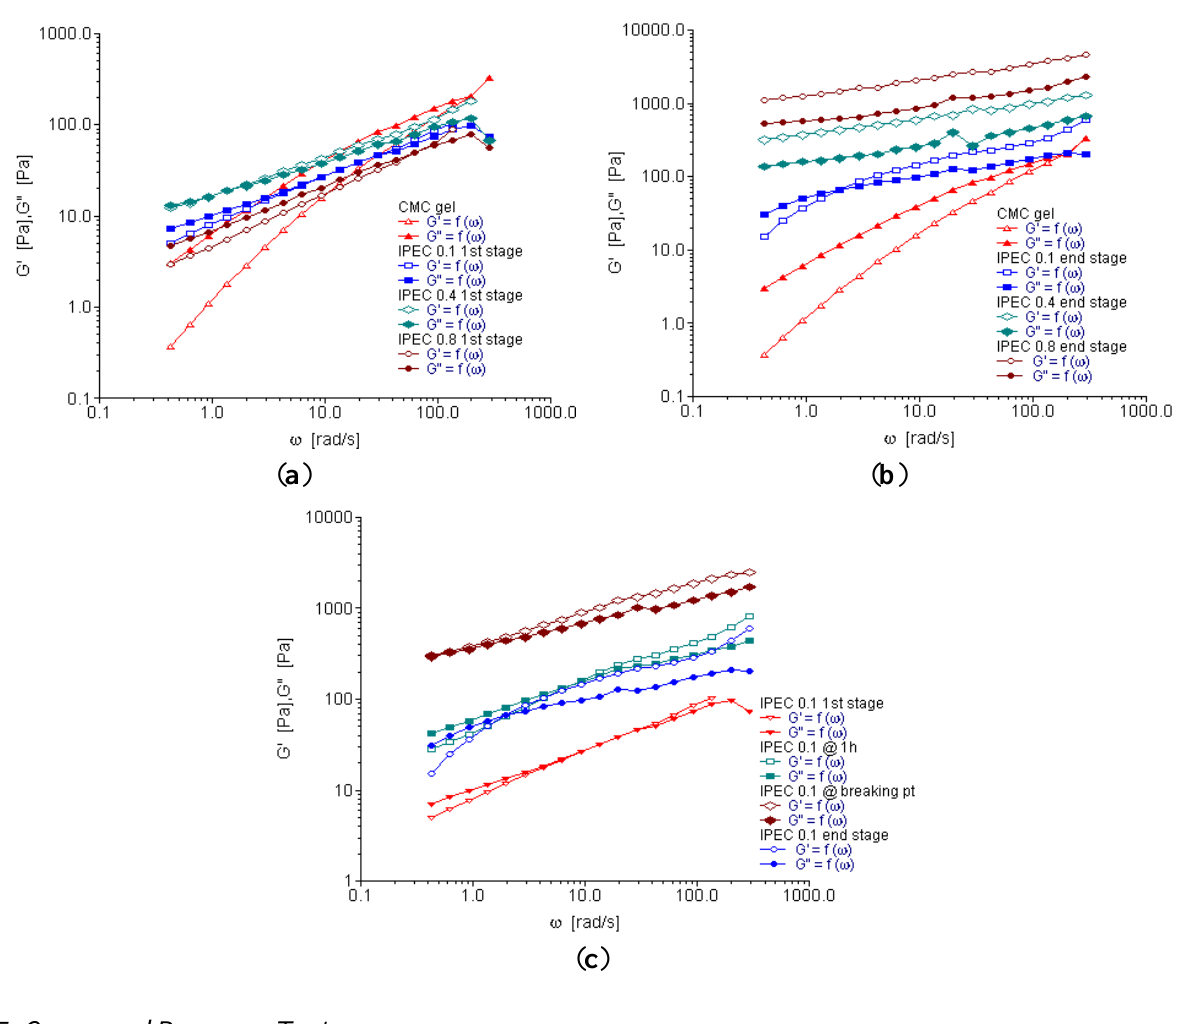
Figure 6. Elastic and viscous modulus as a function of angular frequency for ( a ) NaCMC and IPEC at 1st stage of synthesis; ( b ) NaCMC and IPEC at end stage of synthesis; and ( c ) IPEC 0.1 N at the 4 sampling points of